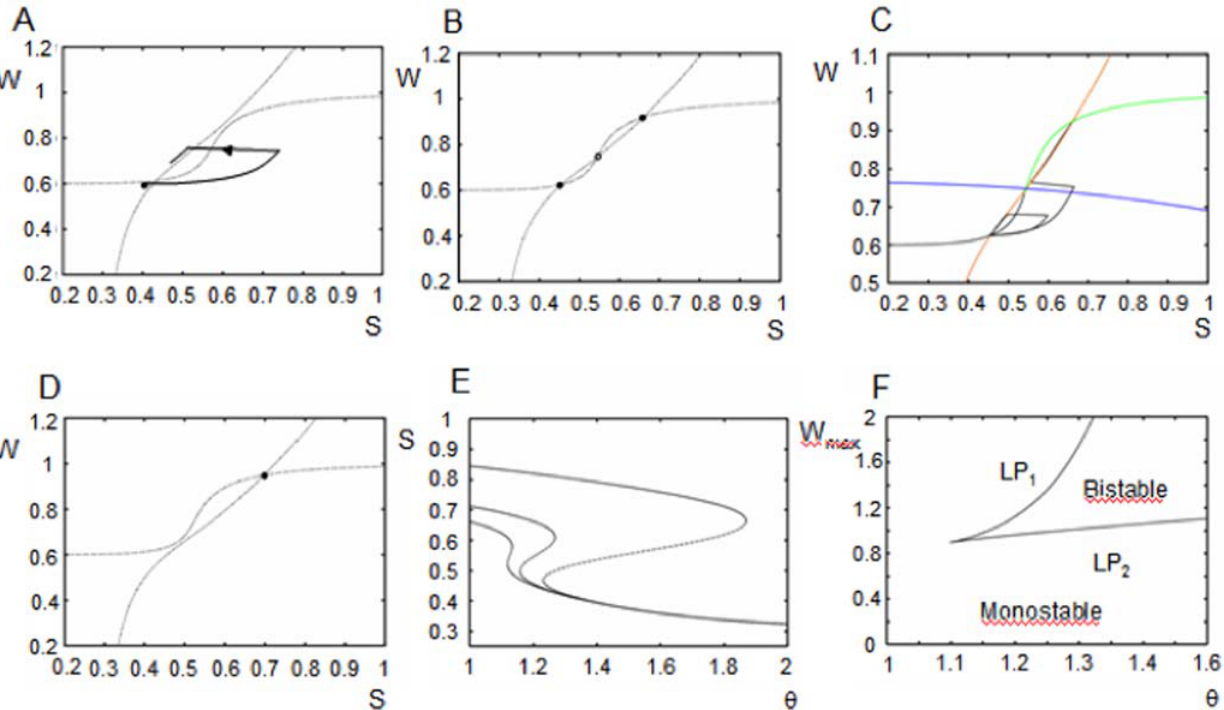
Figure 2. Phase portraits and bifurcation diagrams of the single population reduced model obtained for different values of the self connectivity C 11 and the maximum facilitation W max . The reduced 2-dimensional model is obtained at steady state calcium concentration ( dCa/ dt =0). Shown in the phaseplane are the nullclines for Facilitation ( W ) and Synaptic activity ( S ). A) Nullclines with self connectivity C 11 =4.8. The stable nodes of the system are where the nullclines cross. Here there is a single fixed point (solid black dot) corresponding to the baseline state. The trajectory of the system during a working memory task is indicated by the black line with an arrow. During the sample period, the applied current I(t) raises the synaptic activity, and firing rate, with a concomitant rise in the facilitation (approximately 33% increase). After a 300 ms cue period, I(t) becomes 0, and synaptic activity rapidly decreases towards the facilitation ( W ) nullcline, and the bottleneck. Because of the bottleneck, the trajectory then returns very slowly along the path of the facilitation nullcline towards the stable baseline state. In the present example, the synaptic activity and consequently the firing rate is still above the stable baseline rate at the end of the 10-second delay period, as indicated by the termination of the trajectory line. The system therefore maintains an increase from its baseline firing rate for the duration of the delay period. A continuum of elevated delay rates occur for different values of the parameters. B) W and S nullclines of the single population network with C 11 =5. Note there are now 3 stable points where the nullclines cross: 2 attracting (black dots) and one saddle node (white dot). C) Possible system trajectories of the network in (B) with C 11 =5. The saddle separatrix is indicated by the blue line. Two different possible trajectories of the system are shown which result from varying the magnitude of the external current I(t). For I(t) =0.5 the trajectory does not cross the saddle separatrix and stays in the basin of attraction of the baseline state. In this case, given sufficient time the system returns to the baseline stable state. The resulting pattern of behavior is that of cue- coupled or decaying memory cells. For I(t) =0.75 the trajectory cross the saddle separatrix, entering the baseline of attraction of the higher firing rate stable state. The system for this trajectory is shown to be in the higher firing rate state by the end of the delay period. The resulting pattern of behavior is that of response-coupled or ramping cells. In both cases the bottleneck can be adjusted such that the rate at which the system returns to the baseline state, or approaches the higher firing state can be arbitrarily slow, resulting in a continuum of different average firing frequencies during the delay, and apparent bistability at frequencies between the two stable fixed points. D) Phase portrait with C 11 =5.2. The system again possesses a single stable state at a higher rate than in (A). E) Bifurcation diagram of steady state synaptic activity as a function of maximum facilitation ( W max ). Curves shown are for W max equal to 0.925, 1, and 1.25 (producing synaptic facilitation in the 30–60% range). Solid lines indicate stable fixed points, hashed lines are unstable fixed points. Note that 3 fixed points are present over a wide range of the facilitation. F) Bifurcation diagram for the parameters of maximum facilitation W max and the threshold h . The curves correspond to the limit points at different values of these parameters. The two branches of the limit points meet at a cusp point. For the region interior to the two curves there are three rest states and bistability, and outside them there is a single rest state and